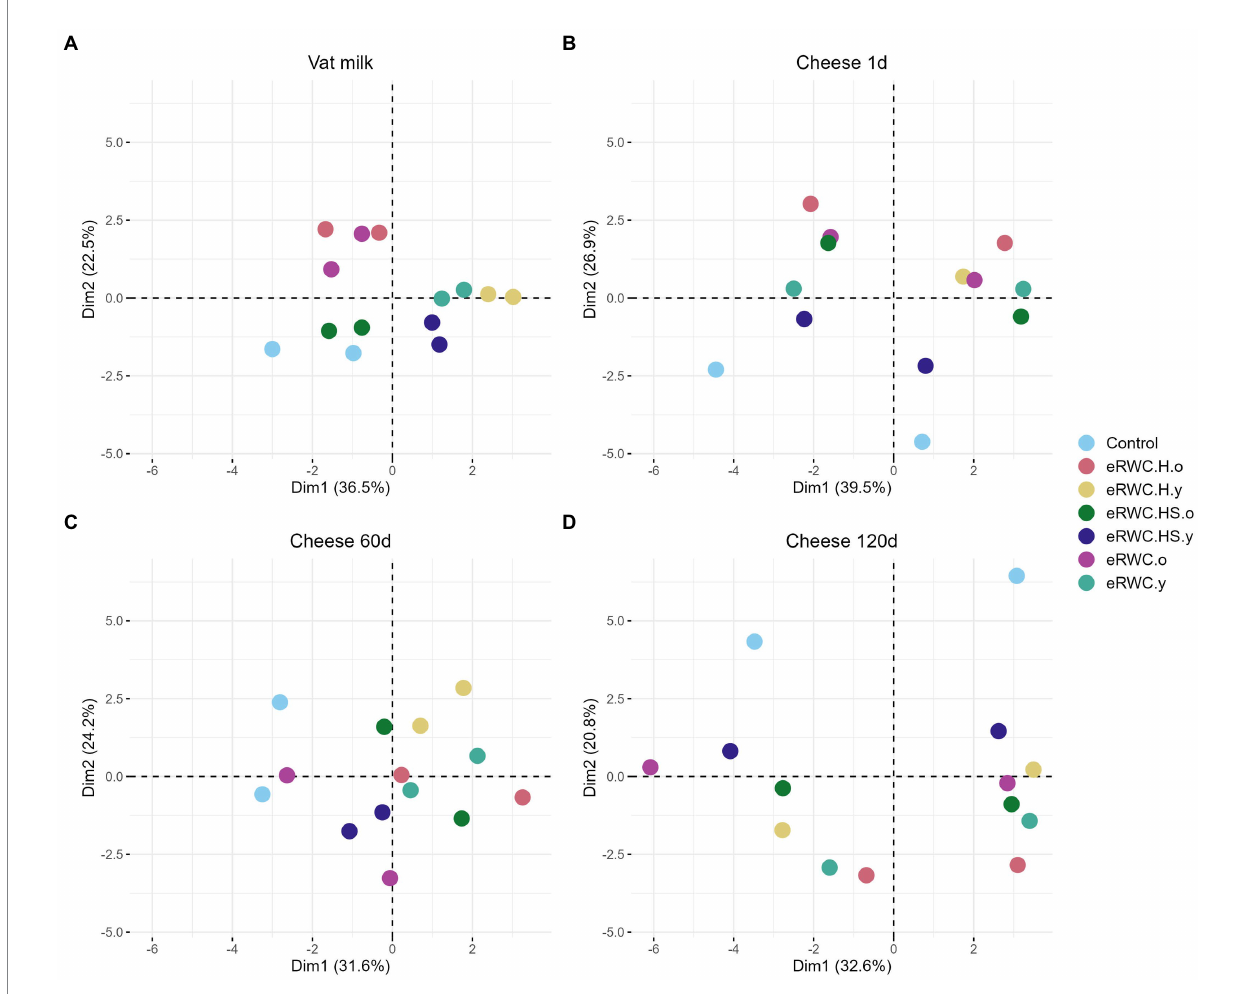
FIGURE 5 Ordination plots of principal component analysis: (A) vat milk, microbial features ( n = 14); (B) 1 d cheese, microbial ( n = 14) and chemical features ( n = 7); (C) 60 d cheese microbial features ( n = 14); (D) 120 d cheese, microbial ( n = 14) and chemical features ( n = 29). Refer to Figure 1 for samples’